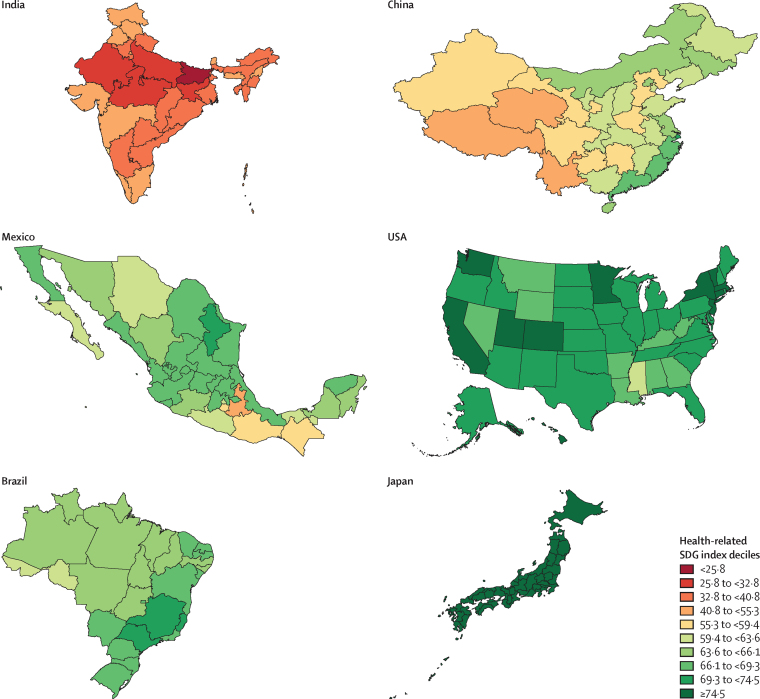
Health-related SDG index for selected subnational locations, 2017Deciles are based on the distribution of health-related SDG indices for countries and territories in 2017, and then applied for subnational locations. SDG=Sustainable Development Goal.